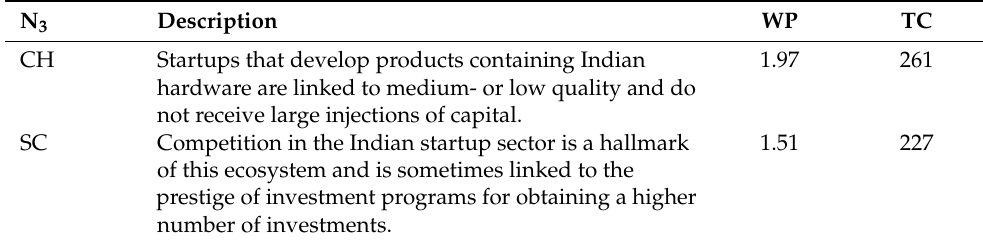
Table 6. Results for N3 for startups negative key indicators for